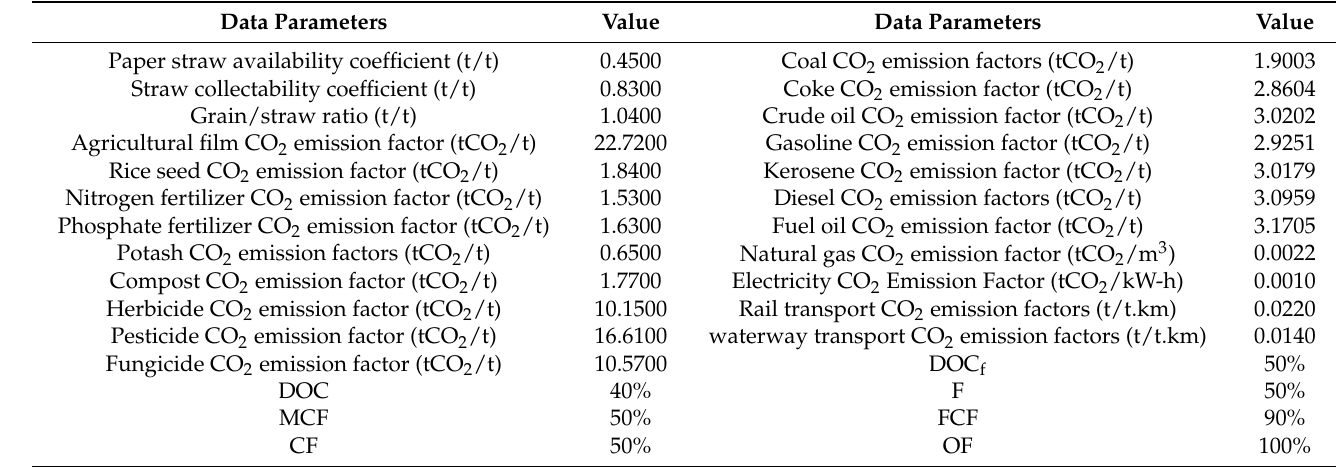
Table 2. Summary of data parameters related to CO 2 emissions of paper products.